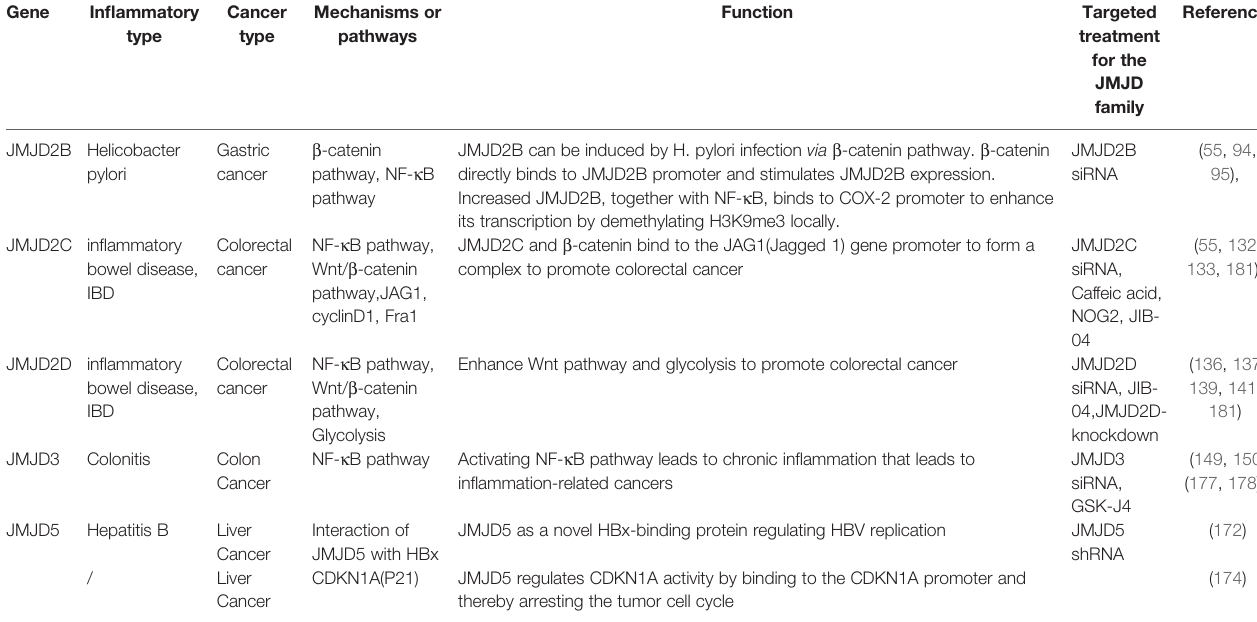
TABLE 1 | The mechanism and target therapies of JMJD protein family in in fl ammatory tumor. Gene In fl ammatory